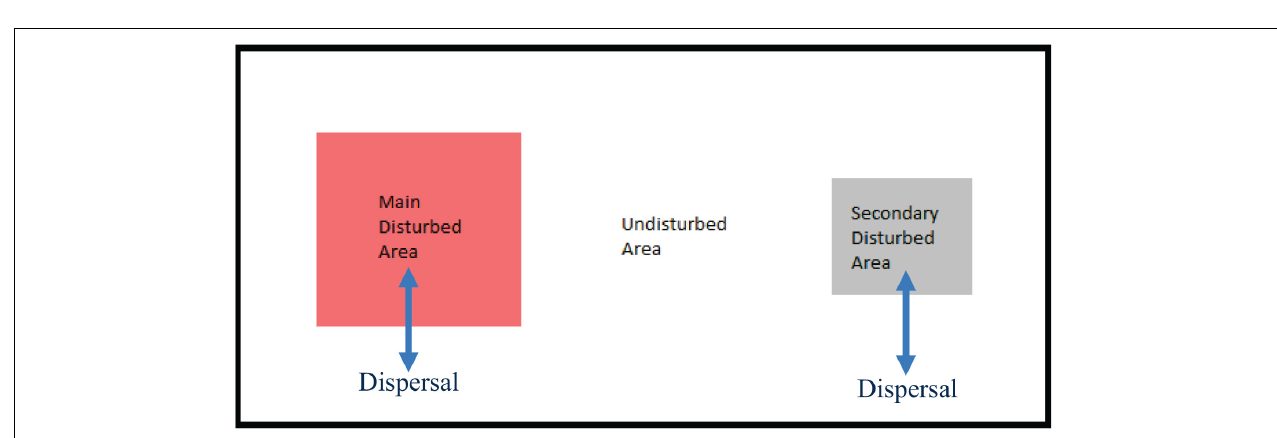
FIGURE 2 | Map of study area: The Atlantic Rim Natural-Gas Development. The black dots indicate the location of active wells in 2010 (U.S. Bureau of Land Management, 2007) and the shaded area indicates the aggregate disturbed areas from a 1 km radius around each well, which is consistent with Powell (2003); Sawyer et al. (2006), and Walker et al. (2007). The upper right two maps show the location of Wyoming and the ARNG inside Wyoming.